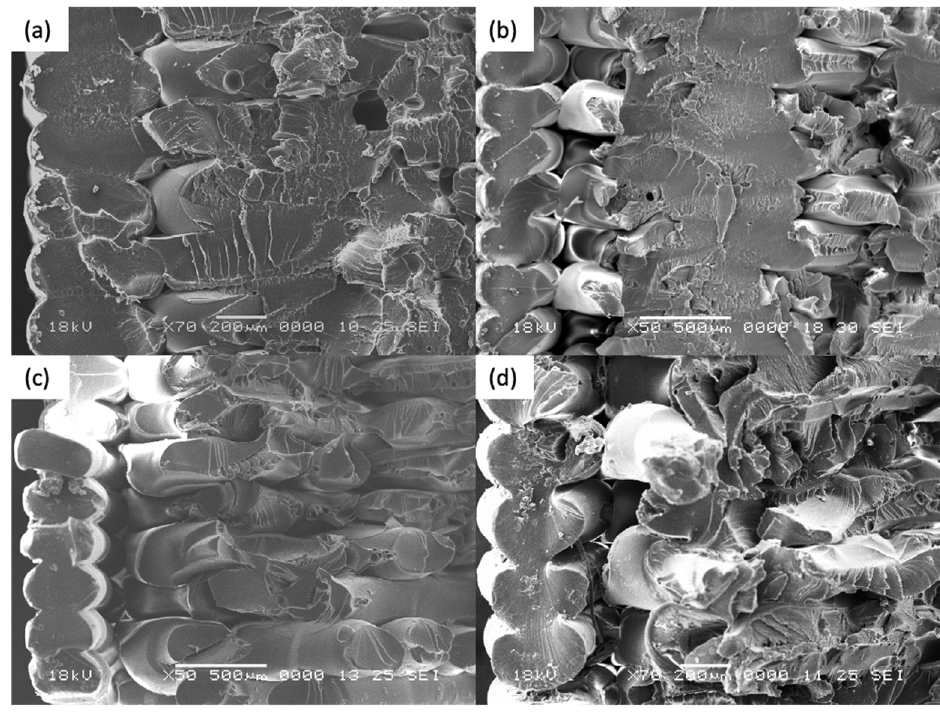
Figure 12. Fracture surface for ( a ) Coupon 2, ( b ) Coupon 6, ( c ) Coupon 7, and ( d ) Coupon XZ2.